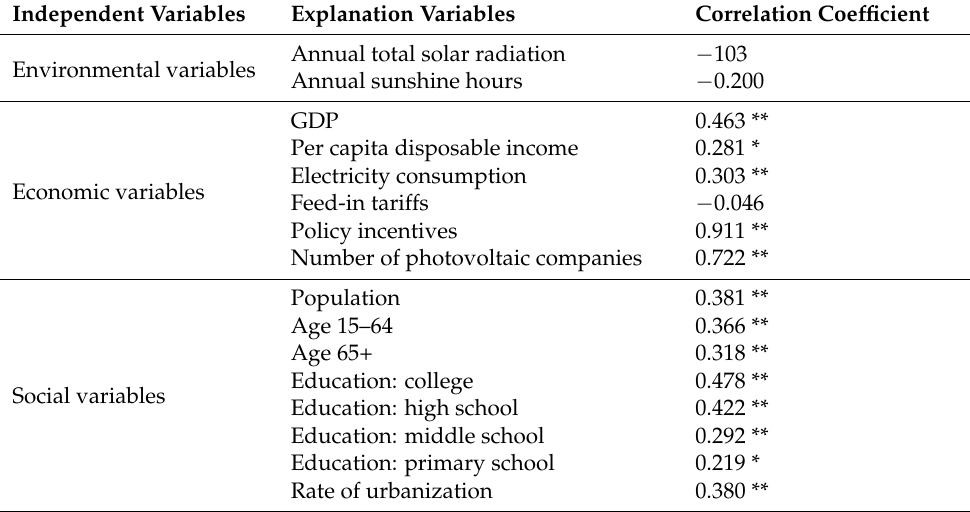
Table 1. The results of the correlation analysis at the ZIP code level.